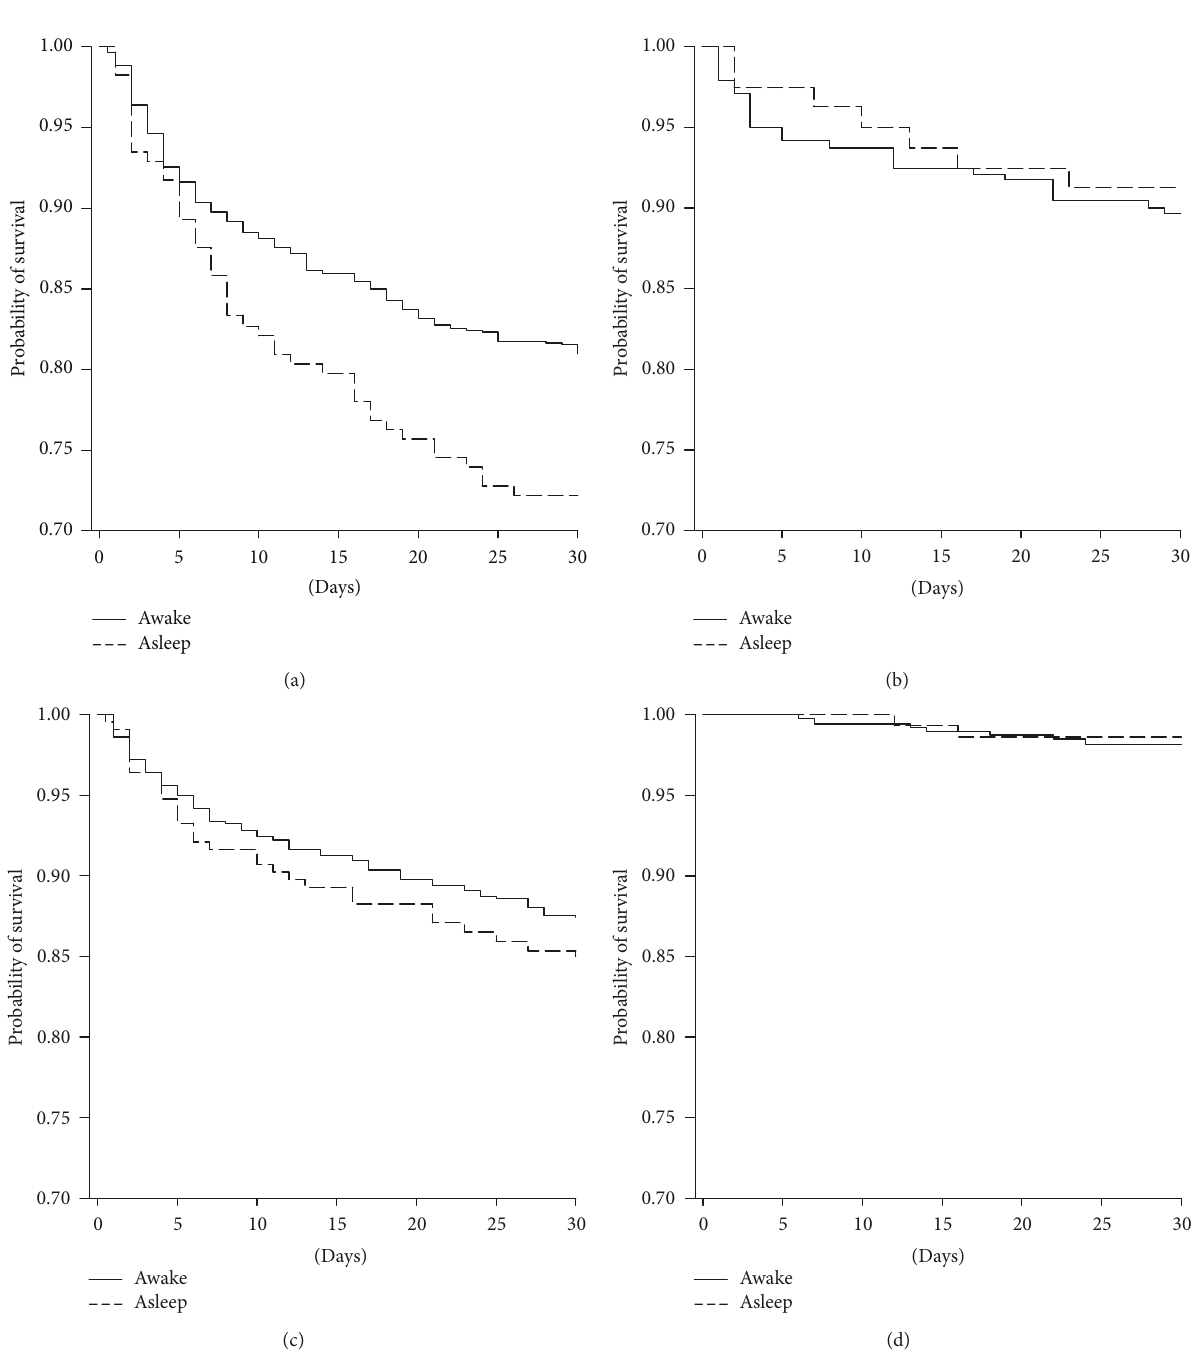
Figure 2: Short-term survival probability (Kaplan-Meier estimates) between awake and asleep onset in (a) CE, (b) AT, (c) CRY, and (d) LA stroke. (a) = 𝑝 = 0.01 and (b), (c), and (d) =